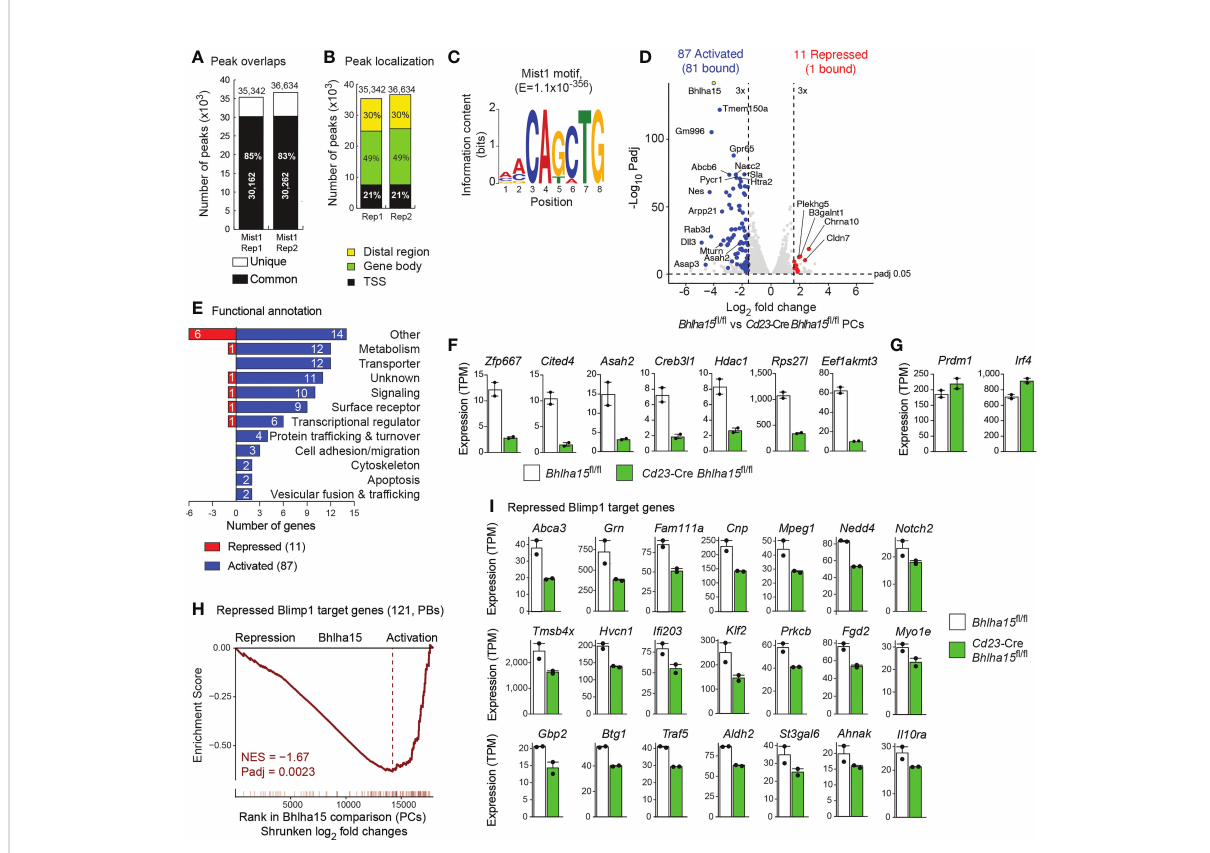
FIGURE 5 Mist1-dependent gene expression program in plasma cells. (A – C) Genome-wide Mist1 binding in PBs that were in vitro differentiated for 4 days by LPS stimulation of CD43 – B cells from the spleen of Bhlha15 fl / fl Rosa26 BirA/BirA mice. CD138 + PBs, which were puri fi ed by immunomagnetic enrichment with CD138-MicroBeads, were used for Bio-ChIP-seq analysis (22), and Mist1 peaks were identi fi ed by MACS peak calling with a stringent P value of < 10 – 10 . (A) Overlap and number of Mist1 peaks identi fi ed in two Bio-ChIP-seq replica (Rep) experiments. (B) Presence of Mist1 peaks in distal regions, gene bodies and promoter (TSS) regions. Mist1 peaks were assigned to genes, as described (22). (C) Consensus Mist1-binding motif identi fi ed with an E-value of 1 x 10 -356 by the de novo motif-discovery program MEME-Chip. (D) Volcano plot of gene expression differences between Cd23- Cre Bhlha15 fl / fl and control Bhlha15 fl / fl PCs that were sorted as TACI + CD138 + cells from the spleen at day 7 after NP-KLH immunization. Two independent RNA-seq experiments were performed with PCs of each genotype. Each dot corresponds to one gene, whose expression is plotted as log 2 -fold change against the -log 10 adjusted P value. Genes with an expression difference of > 3-fold, an adjusted P value of < 0.05 and an expression value of > 5 TPM (at least in one sample) are colored in blue or red corresponding to activation or repression by Mist1, respectively. (E) Functional classi fi cation and quanti fi cation (number) of proteins encoded by Mist1-activated and Mist1-repressed genes. (F) Expression of selected activated Mist1 target genes in Cd23- Cre Bhlha15 fl / fl and Bhlha15 fl / fl PCs. (G) Expression of Prdm1 and Irf4 in Cd23- Cre Bhlha15 fl / fl and Bhlha15 fl / fl PCs. (H) GSEA analysis of 121 repressed Blimp1 target genes (3), as compared to their ranked shrunken log expression changes in Cd23- Cre Bhlha15 fl / fl PCs versus Bhlha15 fl / fl PCs. NES, normalized enrichment score. (I) Expression of repressed Blimp1 target genes in Bhlha15 fl / fl and Cd23- Cre Bhlha15 fl / fl PCs, as determined by RNA-seq. All depicted genes are signi fi cantly deregulated with an adjusted P value of <